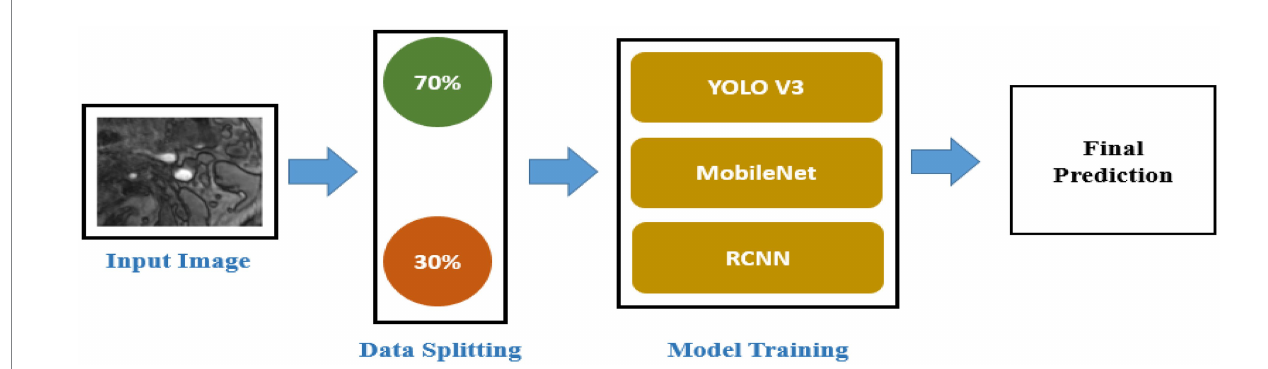
FIGURE 1 Proposed framework.